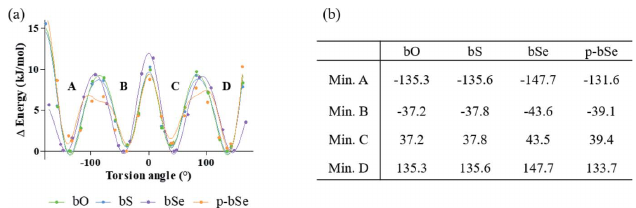
Figure 9 Conformational scans and associated torsion angles calculated with Gaussian16a ( ! B97XD, 6–31+G*).